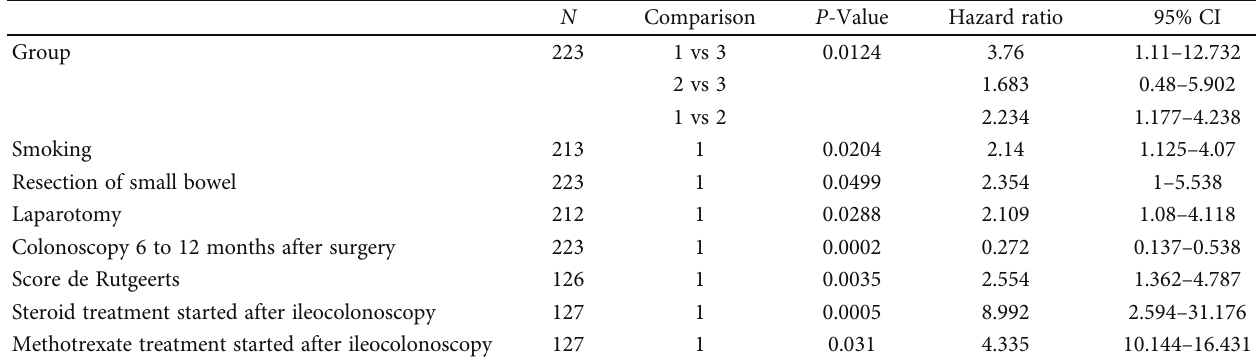
Figure 2: Kaplan – Meier curve of surgical relapse observed in the three cohorts. There was a statistically signi fi cant di ff erence between group C and the other two cohorts (Log-Rank test: p = 0 : 0089 ). Table 2: Predictive factors of post-operative surgical recurrence in univariate analysis.